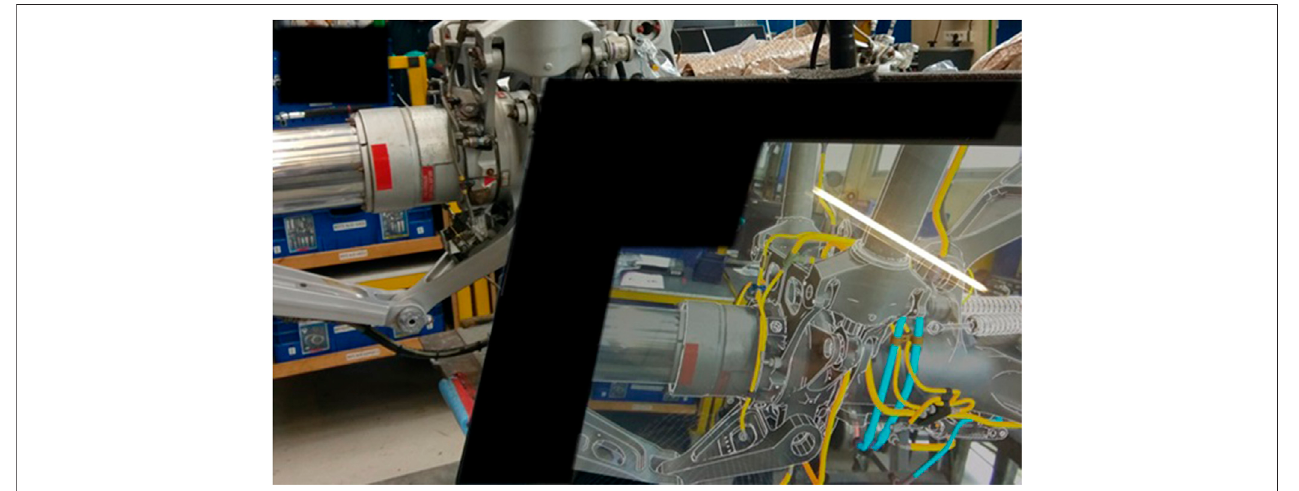
FIGURE 1 | Example of use of an AR tool to assist in a task of aeronautical maintenance.